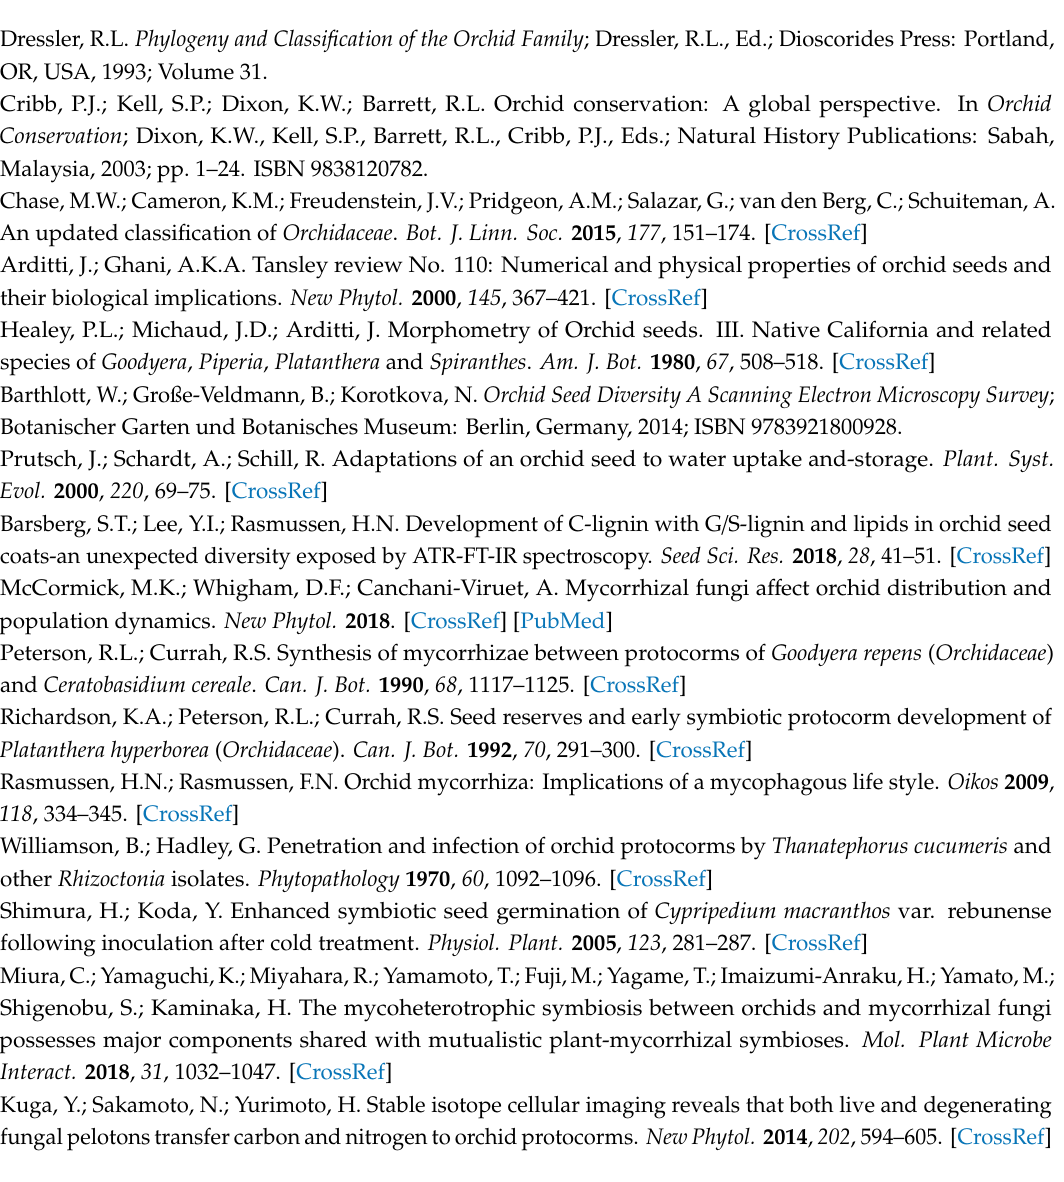
Figure S1: Seed germination of Bletilla striata in axenic culture, Figure S2: Seed germination of Bletilla striata inoculated with Sebacina vermifera , Figure S3: The criteria for infection of Bletilla striata seeds by pathogenic fungi Rhizoctonia solani or Fusarium oxysporum